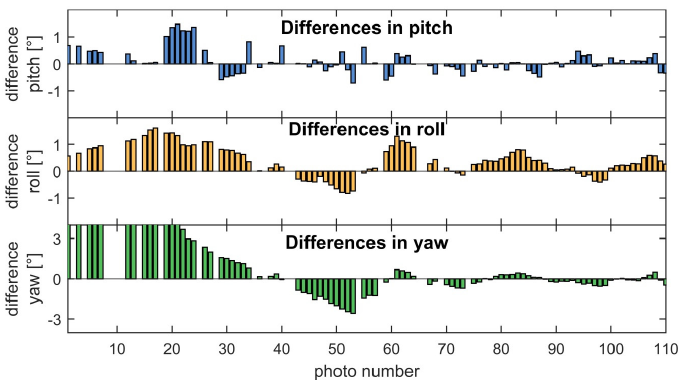
Figure A1. The differences between the indirect (SfM-computed) angles and those from the GPS/INS for the photographs of Flight 2 after the applied mounting calibration.